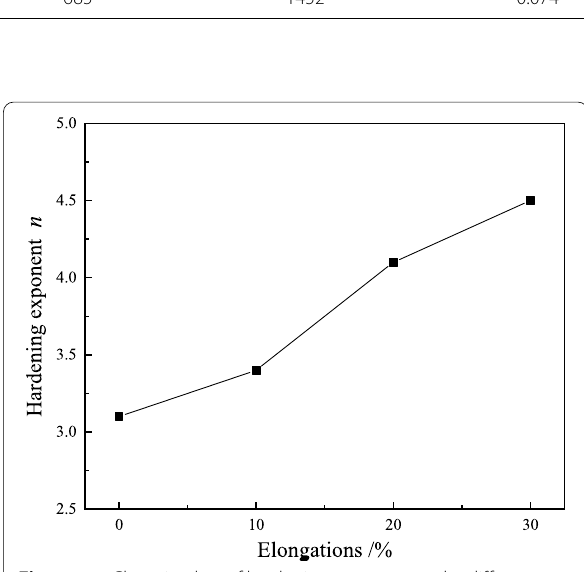
Figure 14 Changing law of hardening exponent under different